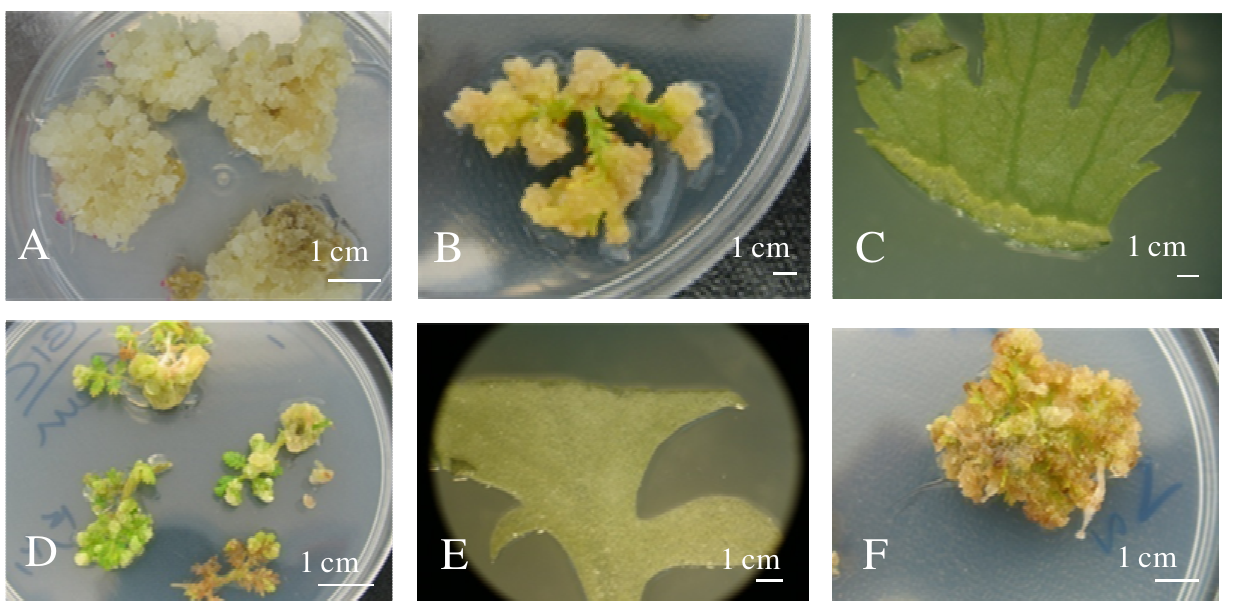
Fig. 3. Shoot induction in the medium containing 0.1 mg/L NAA + 2 mg/L BAP from leaf explants after 2 weeks (A) and after one month (B)